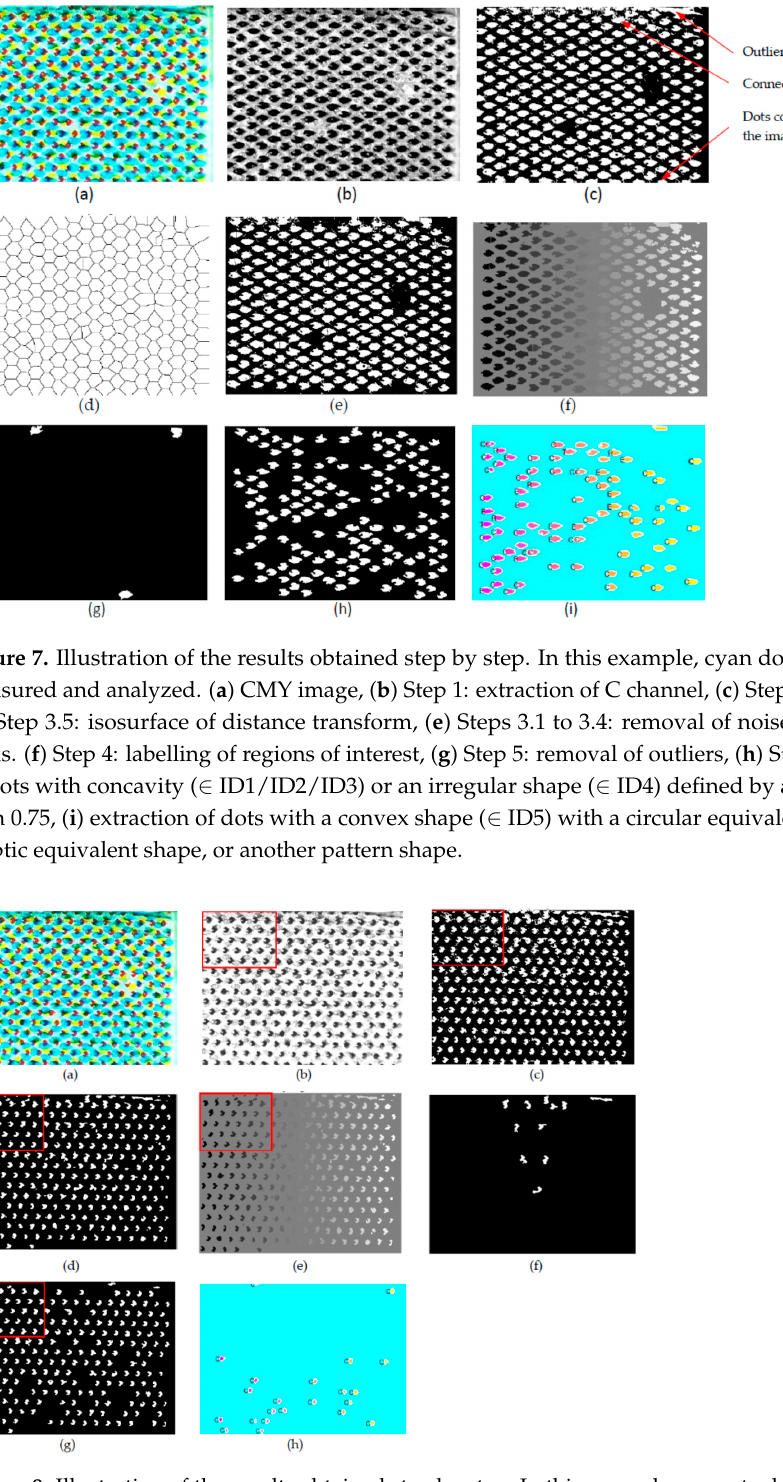
Figure 8. Illustration of the results obtained step by step. In this example magenta dots are extracted, measured and analyzed. The red windows correspond to the image areas shown in Figure 3. (a) CMY image, (b) Step 1: extraction of Magenta channel, (c) Step 2: binarization, (d) Steps 3.1 to 3.4: removal of noise and irrelevant areas, (e) Step 4: labelling of regions of interest, (f) Step 5: removal of outliers, (g) Step 7: extraction of dots with a concavity ( ∈ ID1/ID2/ID3) or an irregular shape ( ∈ ID4) defined by a solidity upper than 0.75, (h) extraction of dots with a convex shape ( ∈ ID5) with a circular equivalent shape, or an elliptic equivalent shape, or another pattern shape.